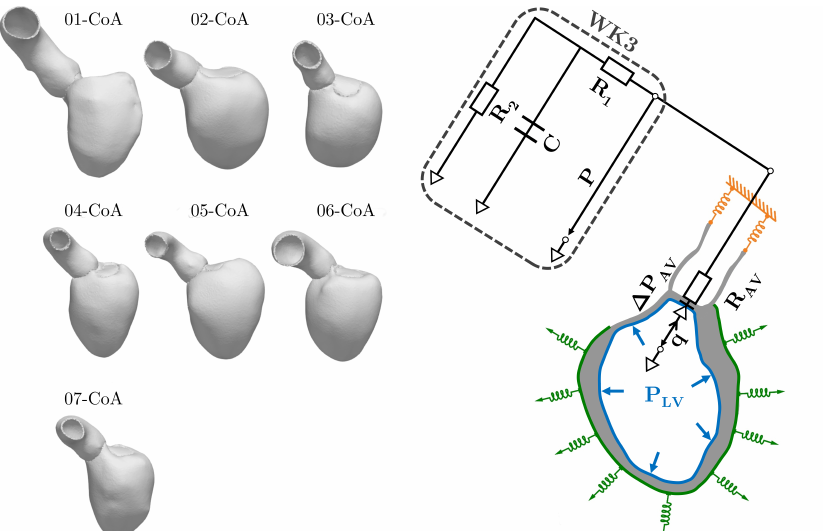
Figure 1. ( Left ), seven patient-specific anatomical models of the left ventricle (LV) and the aortic root from patients treated for aortic coarctation (CoA); ( right ), mechanical and afterload boundary conditions where Neumann-type pressure boundary conditions are illustrated in blue and Robin- type boundary conditions are illustrated in green (uni-directional springs that mimic the effect of the pericardium) and yellow (omni-directional springs). The mechanical model is coupled to a 0D three-element Windkessel model (WK3) that accounts for afterload conditions. Here, R 1 , R 2 are the characteristic and peripheral resistances, respectively, and C is the arterial compliance. Pressure is denoted by P and the relationship between pressure and flow q = d V across the aortic valve (AV) is d t represented by a 0D diode model, where R AV is the respective resistance. The diode model of the flow across the mitral valve and the uni-directional springs that are applied to the septum are not shown. See [18] for more